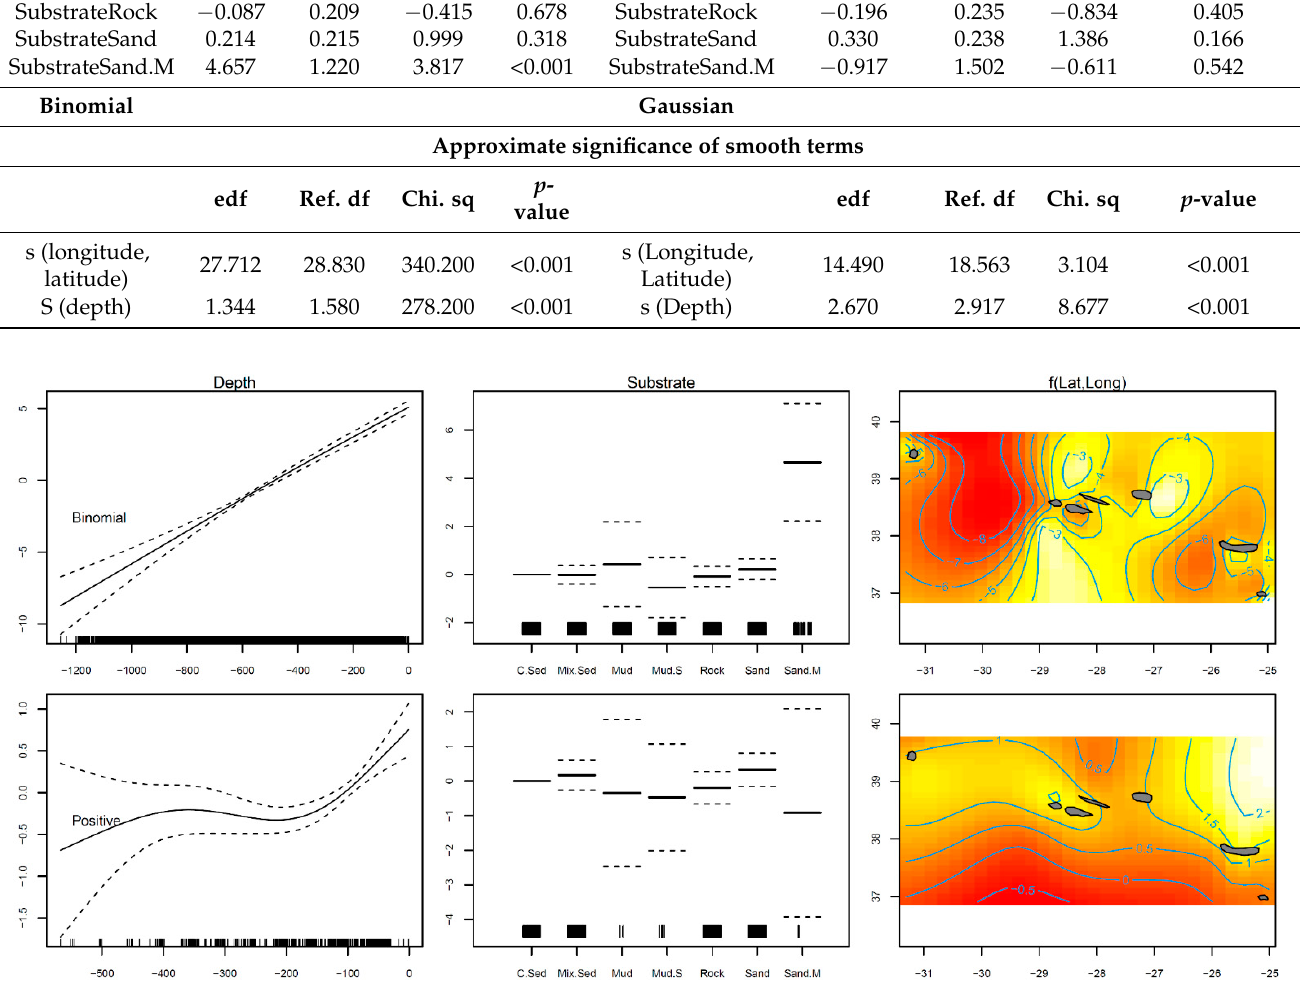
Figure 1. Residual plots for explanatory variables obtained by the presence–absence binomial and positive abundance Gaussian generalized additive models for the thornback ray Raja clavata caught during scientific surveys in the Azores. The smoother fit and ±0.95 confidence intervals are represented as solid and dashed lines, respectively. Tick marks on the x–axis indicate observed data points. White color indicates more individuals and red color fewer in the 2D smoother colored plot.